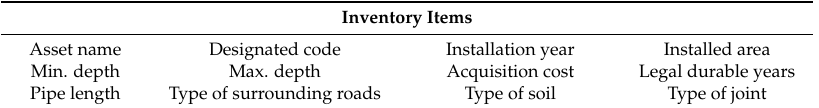
Table 9. Composition of inventory